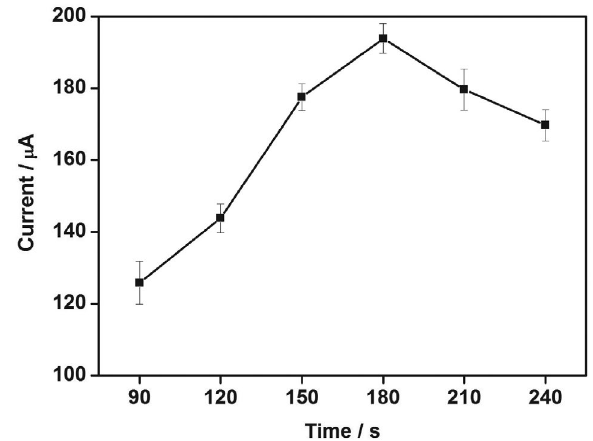
Fig 6. Effects of deposition time on the oxidation peak current of 5.0 mM nitrite at the prepared PEDOT/Fe 3 O 4